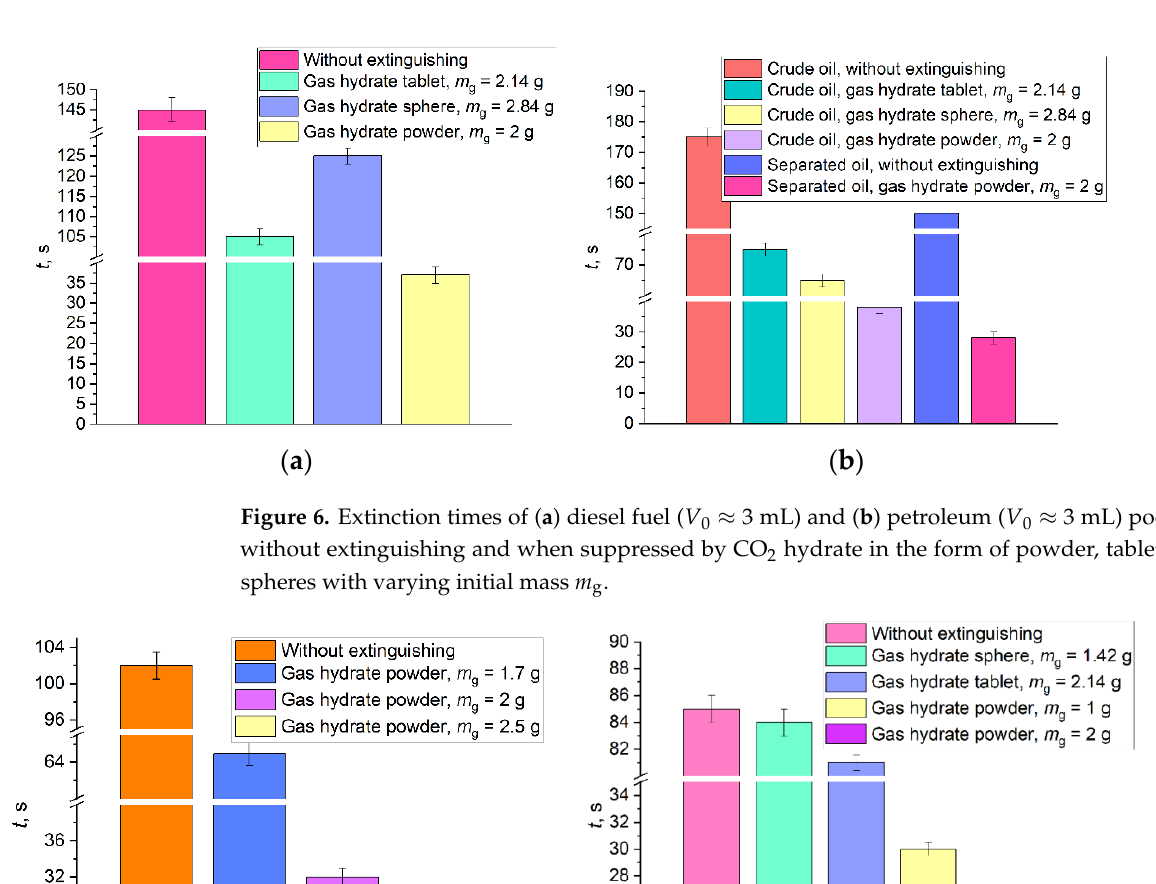
Figure 6. Extinction times of ( a ) diesel fuel ( V 0 ≈ 3 mL) and ( b ) petroleum ( V 0 ≈ 3 mL) pool fires with- out extinguishing and when suppressed by CO 2 hydrate in the form of powder, tablets, and spheres with varying initial mass m g .